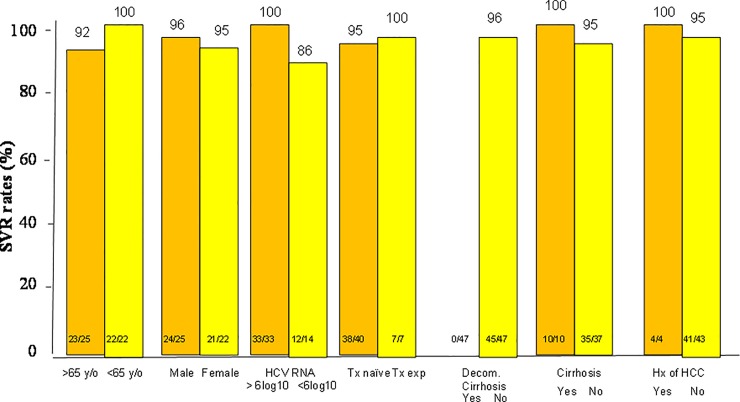
Subgroup analysis of the sustained virologocal response (SVR) rates in patients who received SOF/DCV regimen.SOF: sofosbuvir, DCV: daclatasvir.